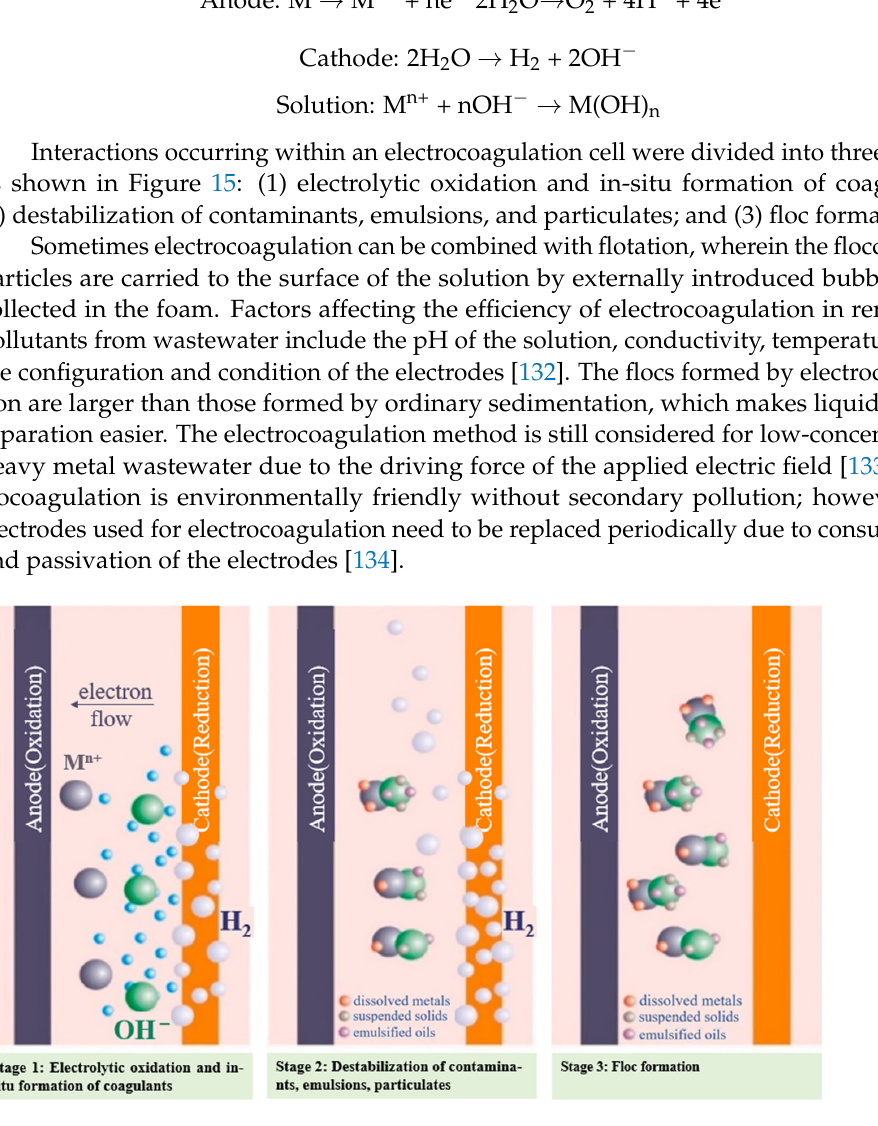
Figure 15. Interactions occur within an electrocoagulation cell based on the three stages, reproduced from [134], with permission from Elsevier, 2022.